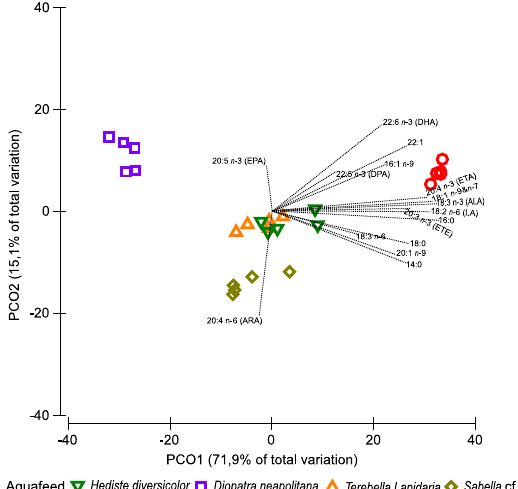
Figure 4. Principal coordinates analysis (PCO) of common fatty acids present in the aquafeed supplied to fish being farmed and the four IMTA-cultured polychaetes ( Hediste diversicolor , Diopatra neapolitana , Sabella cf. pavonina and Terebella lapidaria ) (common with at least one of the species). Average values (± SD) (n = 5). ALA alpha-linolenic acid, ARA arachidonic acid, DHA docosahexaenoic acid, DPA docosapentaenoic acid, EPA eicosapentaenoic acid, ETA eicosatetraenoic acid, ETE eicosatrienoic acid, LA linoleic